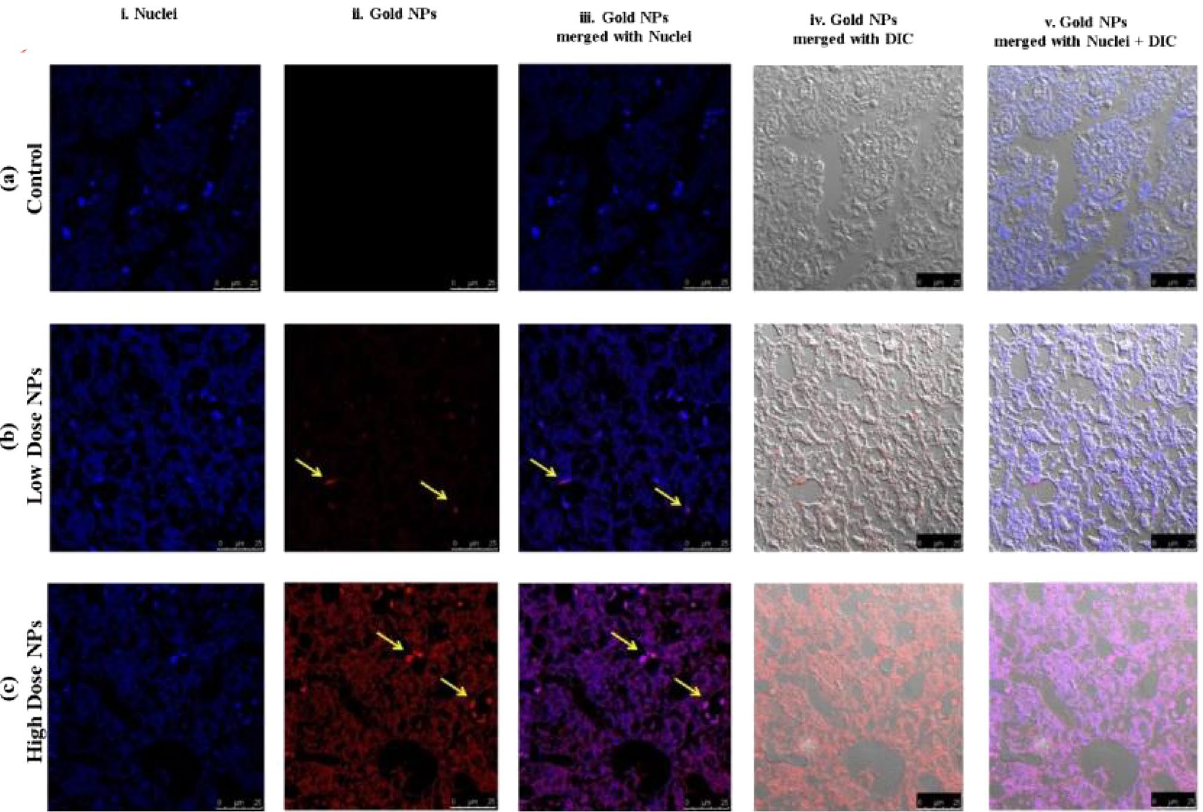
Figure 6. In vivo biodistribution and localization of Au-NPs at different doses (High & Low) in rat liver tissues. The Au-NPs were clearly visible in the cytoplasm and nucleus of liver tissue cells, especially in the sinusoidal macrophages (Kupffer cells) indicating that the macrophages were central in the elimination process of Au-NPs from the body (yellow arrows). (i) Blue: Hoechst 33342-stained nuclei. (ii) Red: Gold NPs. (iii) Merged Image from Gold NPs and Nuclei. (iv) DIC mode merged with Gold NPs (v) DIC mode merged with Gold NPs and nuclei. λ max = 505 nm (Hoechst 33342), 555 nm (red autofluorescence from gold NPs), 473 nm (Differential interference contrast [DIC]). (Confocal Laser Scanning Microscope × 63, Scale bar: 25 μm, Scan Mode = XYZ Unidirectional X, Scan Speed = 400 Hz, Pinhole Diameter = 137.1